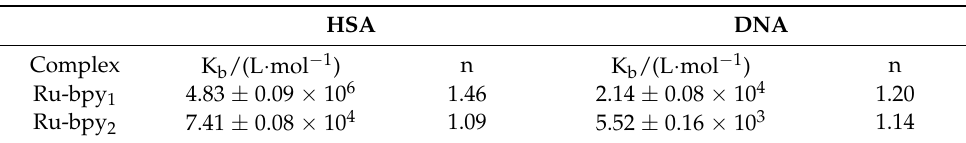
Table 3. The binding constant (K b ) and number of average binding site (n) of two Ru-Lbpy complexes with HSA and DNA.